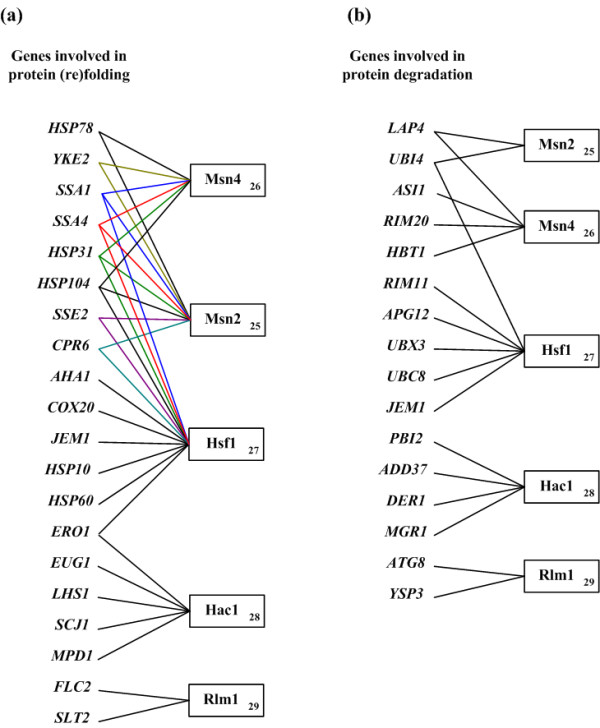
Refining clusters of genes involved in the same cellular process. (A) Refining the cluster of genes involved in protein (re)folding. HIMIA assigns the 20 identified genes that are involved in protein (re)folding into five modules. (B) Refining the cluster of genes involved in protein degradation. HIMIA assigns the 16 identified genes that are involved in protein degradation into five modules.